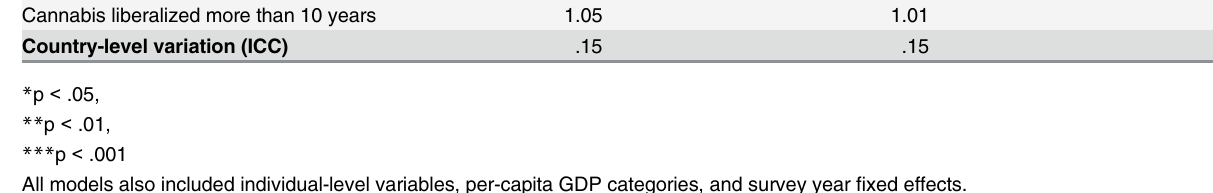
Table 5. Multilevel logistic regressions for adolescent cannabis use status and length of time that cannabis liberalization policies took effect. HBSC 2001 – 2010 (N = 172,894). Ever used cannabis Used cannabis in past year Used cannabis regularly